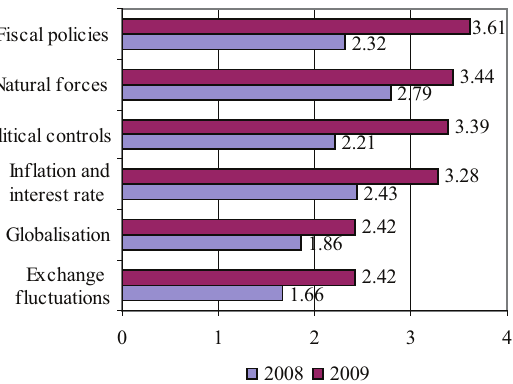
figure 1. Probability assessment of external project risks